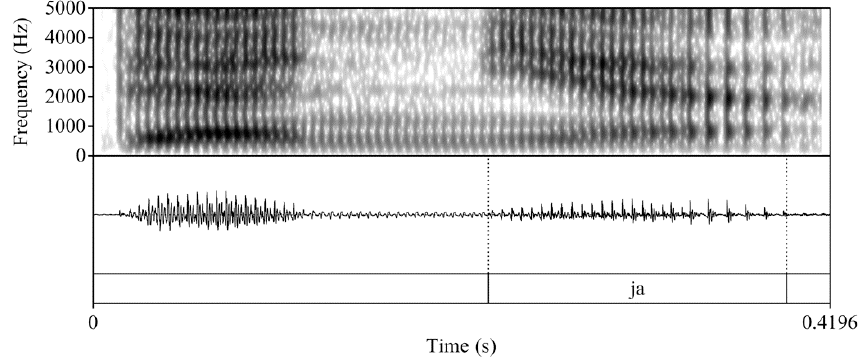
Figure 1. Waveform and spectrogram of a participant’s production of /d ɛnjɑ/ ‘denya’ in English mode.